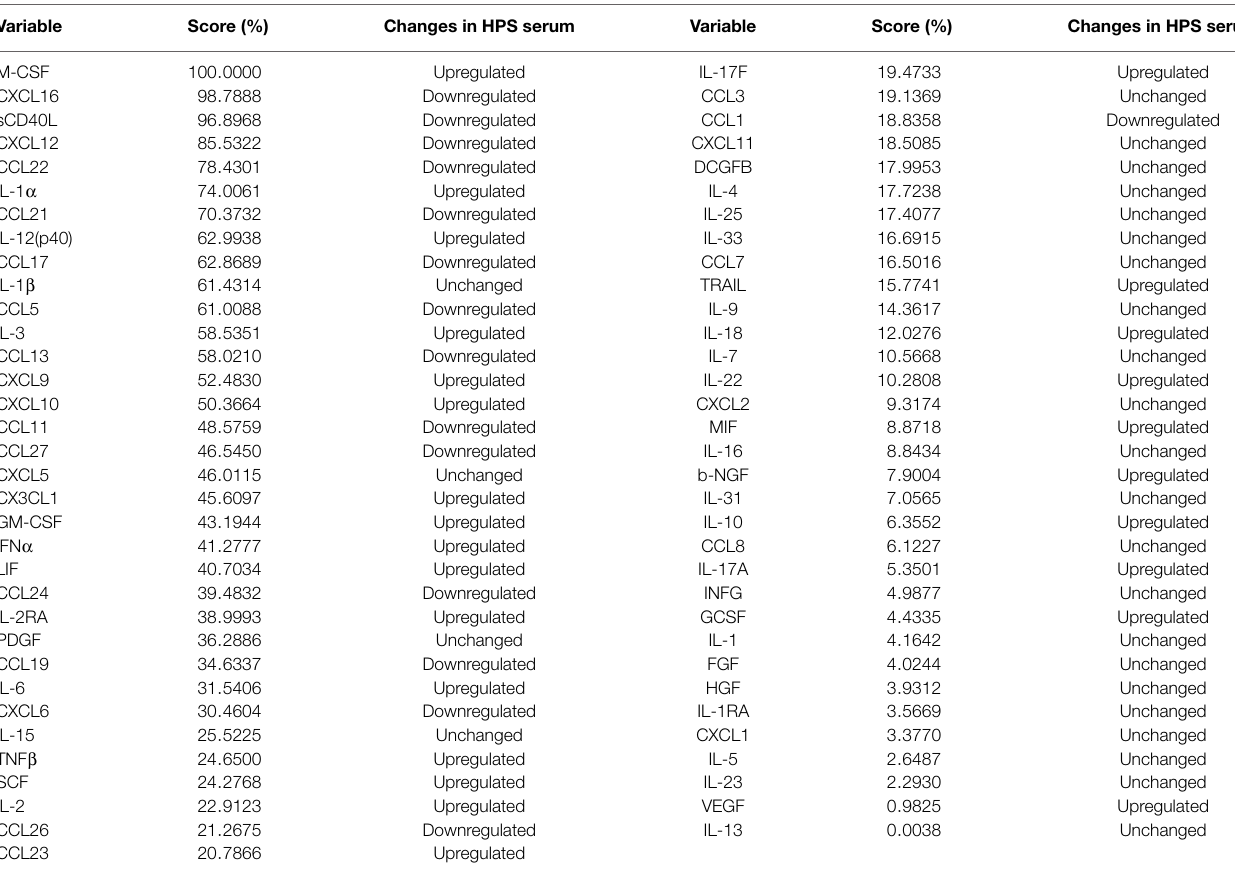
TABLE 6 | Random forest analysis of serum cytokines in HPS vs. controls .